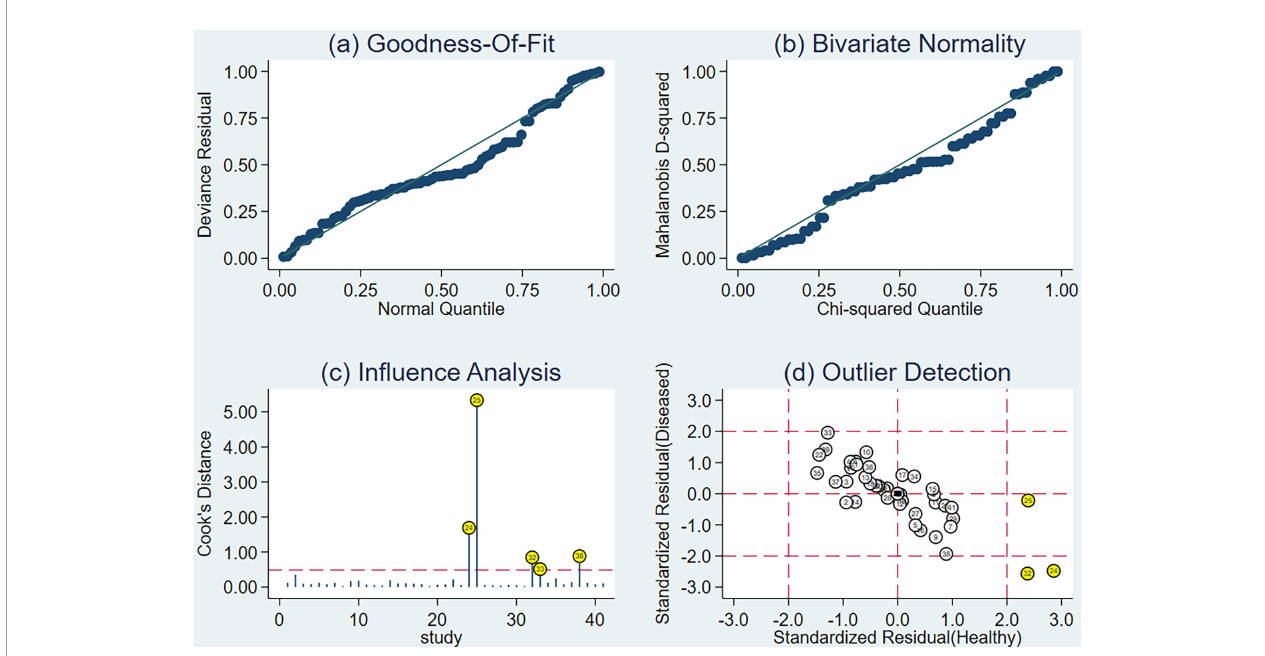
FIGURE 5 | Sensitivity analysis results of all studies: (A) goodness of fi t, (B) bivariate normality, (C) in fl uence analysis, and (D) outlier detection.